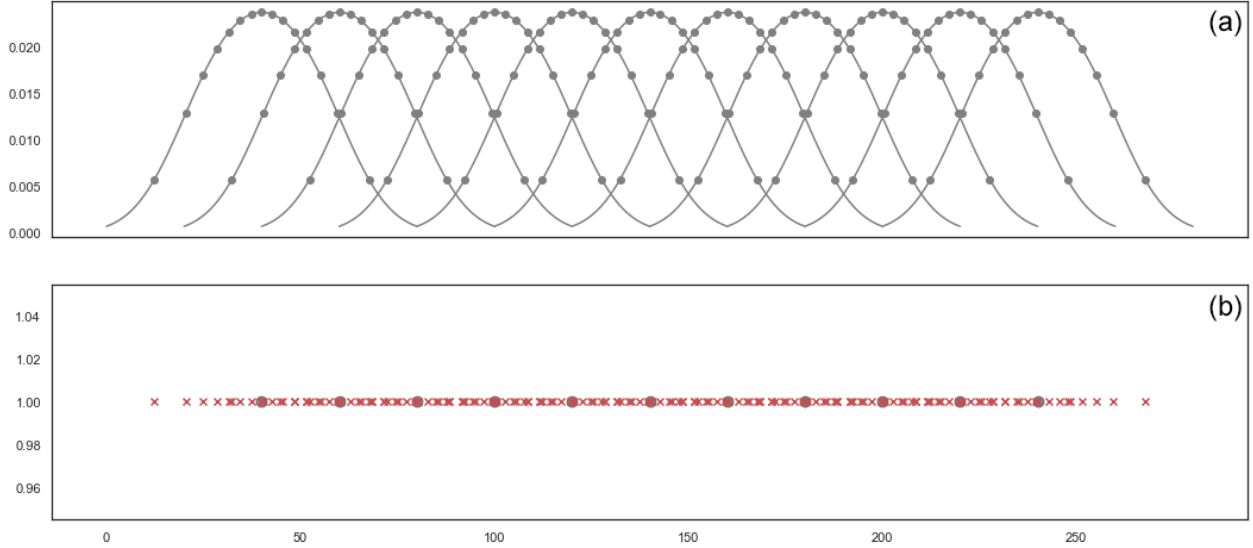
Figure D1. Using 15 points per range gate, the node locations { s k } found by imposing h k ρ(s k ) to be constant for the WindCube V2 RWF for as many nodes as possible. The top panel shows node locations on the overlapping RWF centered at each of the 11 range gates. The bottom panel shows the nodes ( x (cid:48) s) and range-gate centers (dots) along the one-dimensional beam length.